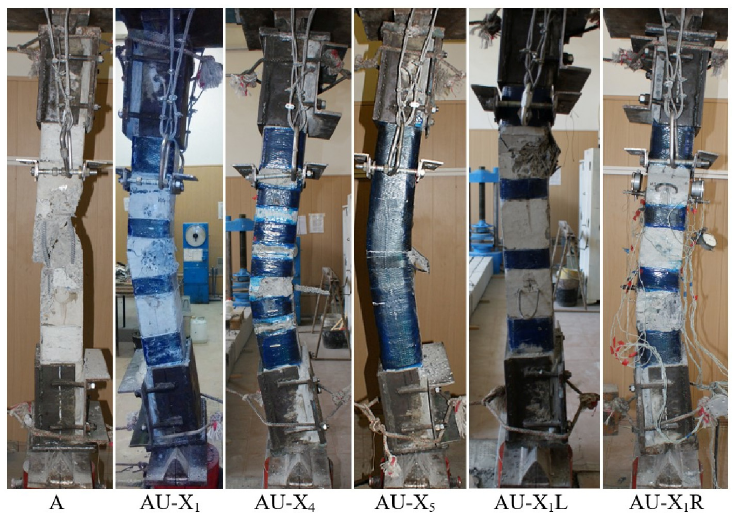
Figure 8. The nature of the destruction of the reference (A) and reinforced (AU) samples with an axial eccentricity of the load application 0 e = 0.